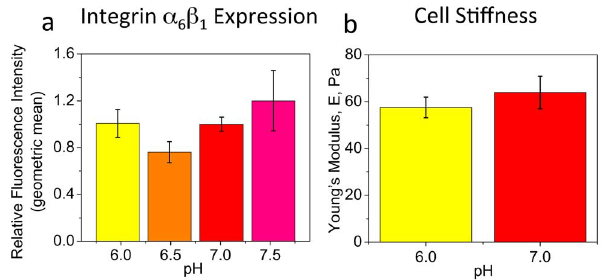
Figure 4. Expression of integrin a 6 b 1 and stiffness of OPCs at different pH. ( a ) Expression level of integrin a 6 b 1 at different extracellular pH, evaluated by OPC immunostaining against a 6 b 1 (with Alexa Fluor-488 fluorochrome) and analysis of cell fluorescence using flow cytometry (BD LSR Fortessa). Data are geometric mean fluores- cence intensities averaged over three experiments, each conducted in triplicate, and presented relative to value obtained for pH 7.0. No statistical difference was observed between any pH conditions. ( b ) Cell stiffness at pH 6.0 and 7.0, evaluated using AFM-enabled nanoindenta- tion. Data are mean of Young’s elastic modulus measured for 15 cells per condition. No statistical difference was observed between pH 6.0 and 7.0. Error bars are SEM. Colors correspond to cell media pH.